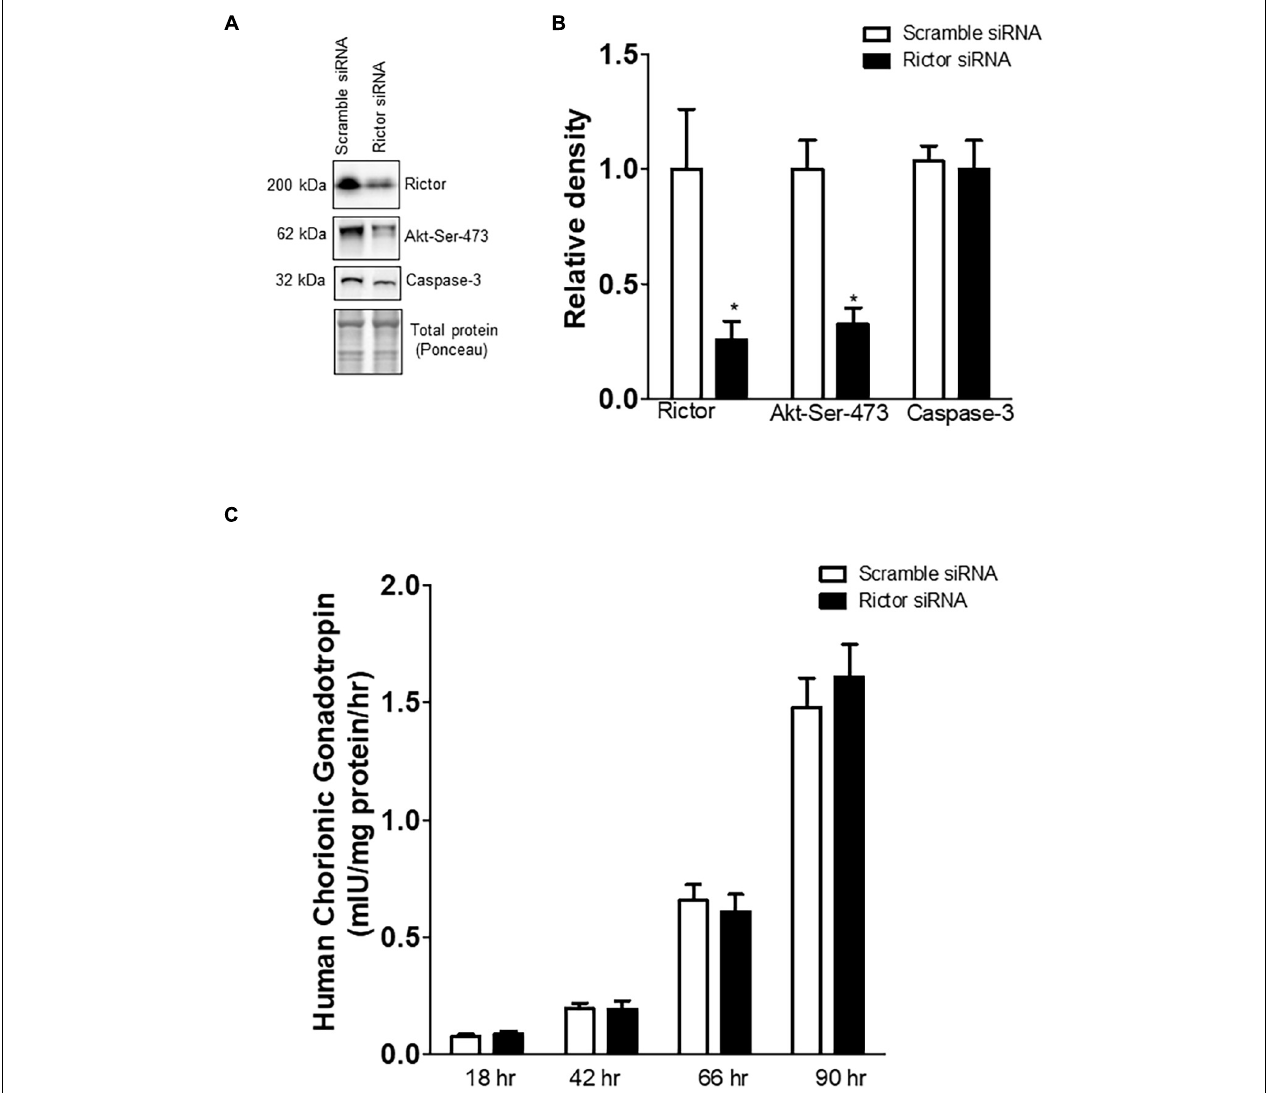
FIGURE 1 | Effect of rictor silencing on rictor protein expression, mTORC2 signaling activity, and trophoblast differentiation and viability. (A) Representative western blots of rictor, phosphorylated Akt-Ser-473 and caspase-3 expression in cell lysates of scramble siRNA and rictor siRNA silenced PHT cells. Equal loading was performed. (B) Summary of the western blot data of rictor, Akt-Ser-473, and caspase-3 protein. (C) Secretion of human chorionic gonadotropin (hCG) from PHT cells transfected with scramble or rictor siRNA. Values are given as means + SEM. * P < 0.05 vs. scramble siRNA; unpaired Student’s t -test; n = 5/each group.